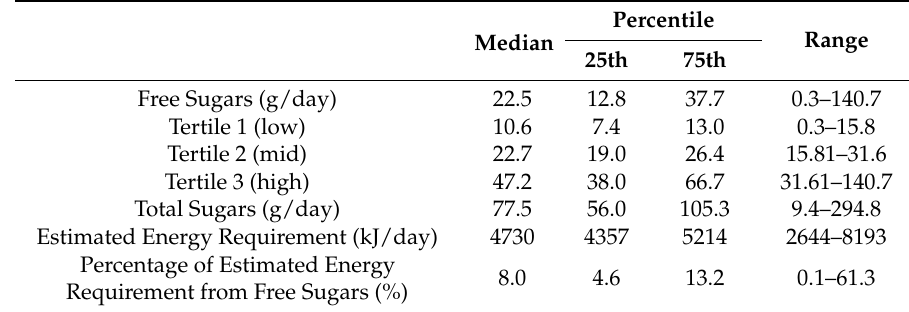
Table 2. Free Sugars intakes at 2 years of age ( n =